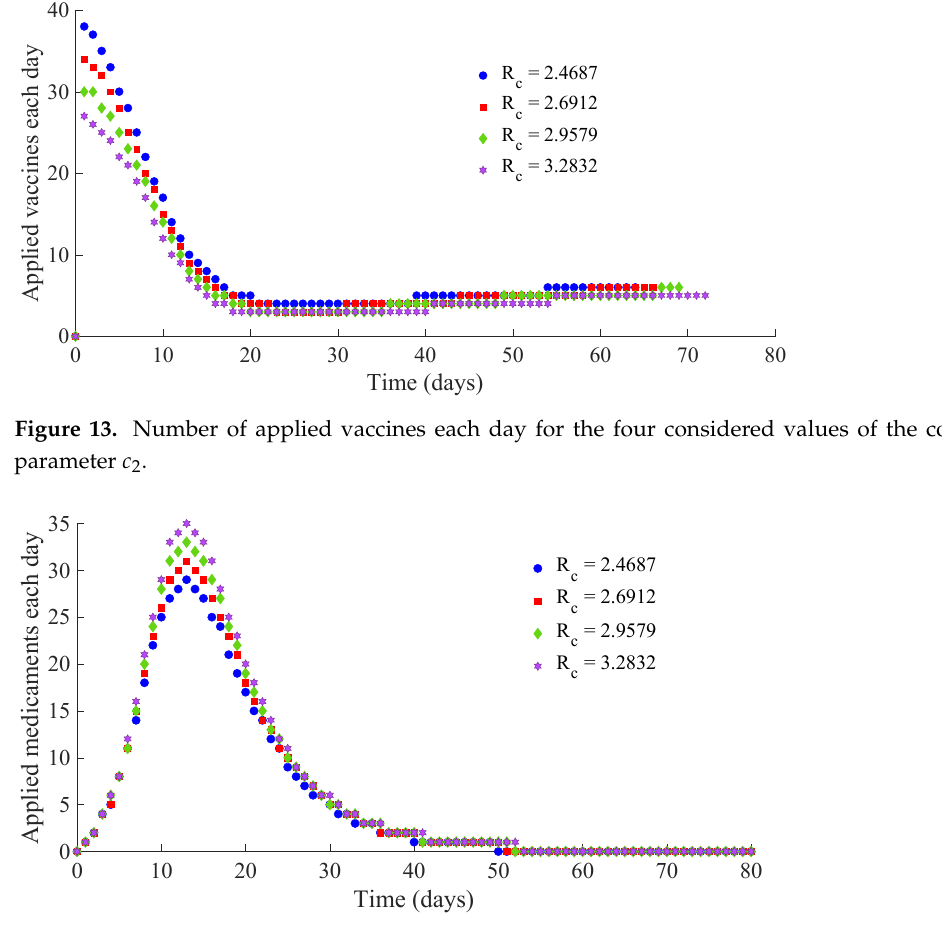
Figure 14. Number of applied medicaments each day for the four considered values of the control parameter c 2